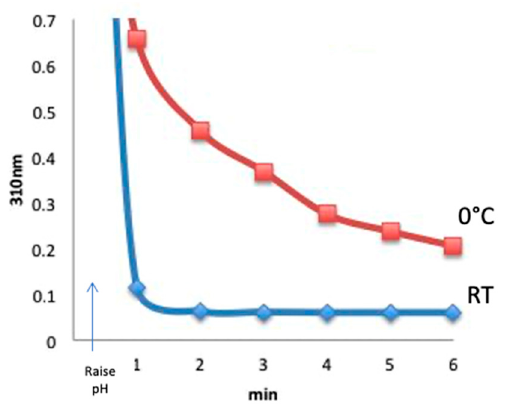
Figure 4. CDAP remaining at room temperature vs. 0 °C. CDAP was added to an aqueous solution at the indicated temperature. At 30 s, the pH was raised to 9 with 0.1 M NaOH. Aliquots were transferred to 0.1 M HCl and the absorbance read at 310 nm.